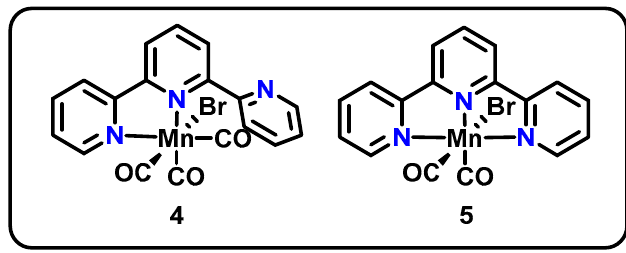
Figure 2. Structures of Mn( κ 2 -tpy)(CO) 3 Br ( 4 ) and Mn( κ 3 -tpy)(CO) 2 Br ( 5 ) [46,47].